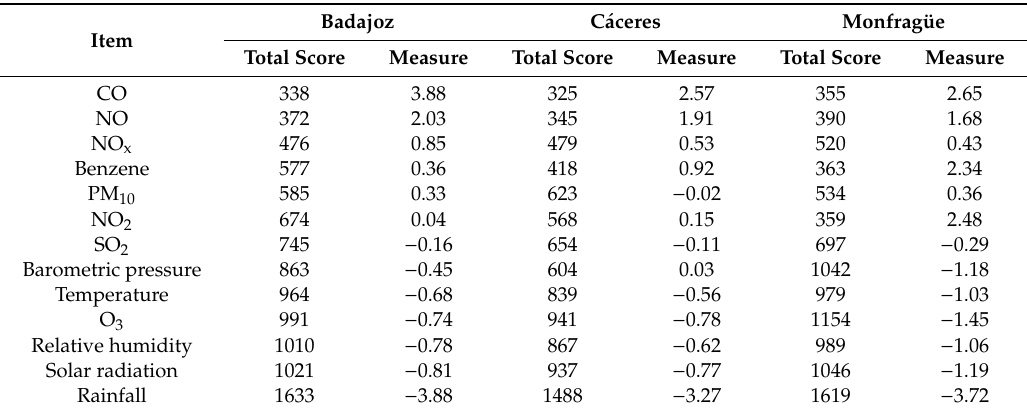
Table 4. Influence of each pollutant and climatic factor on the atmospheric pollution. Total score is the sum of the points of the common scale for each item considering all days in 2016; measure is the atmospheric pollution level. Badajoz C á ceres Monfragüe